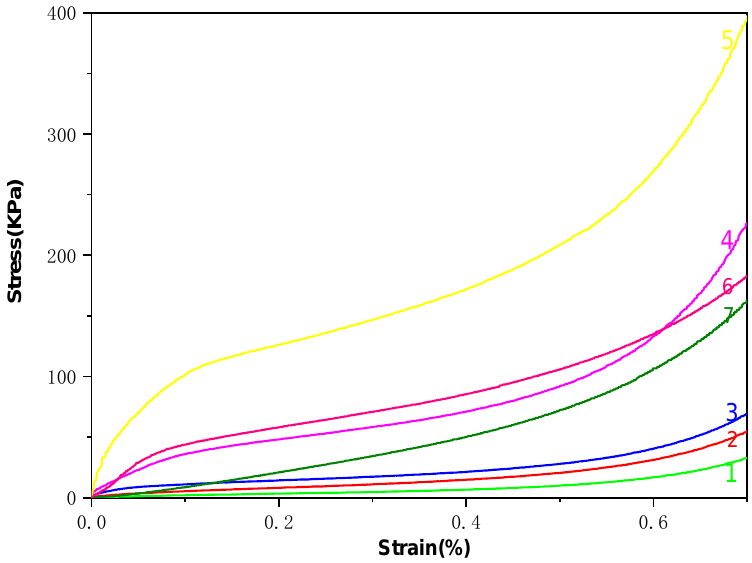
Figure 4. Stress and strain curves for materials with different PVA contents.